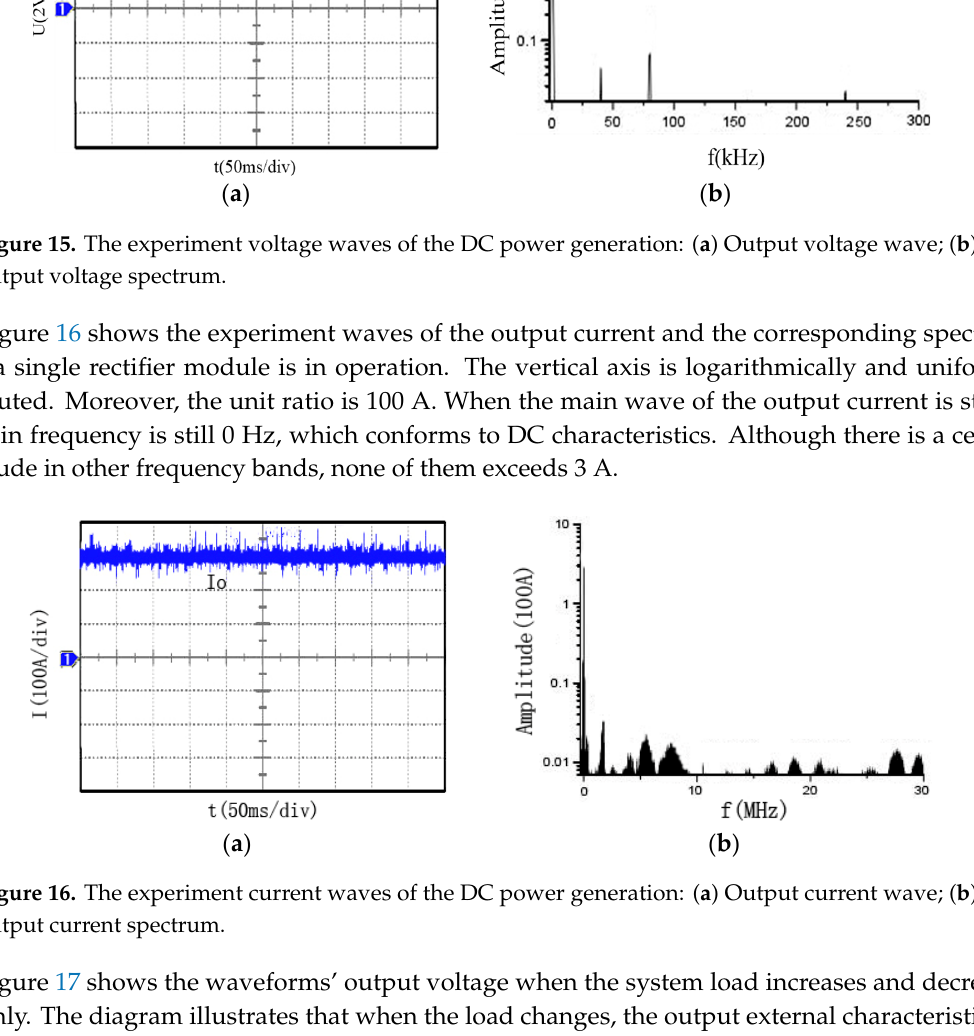
Figure 17. Output voltage waves of resistance mutation: ( a ) Load increases; ( b ) load decreases.